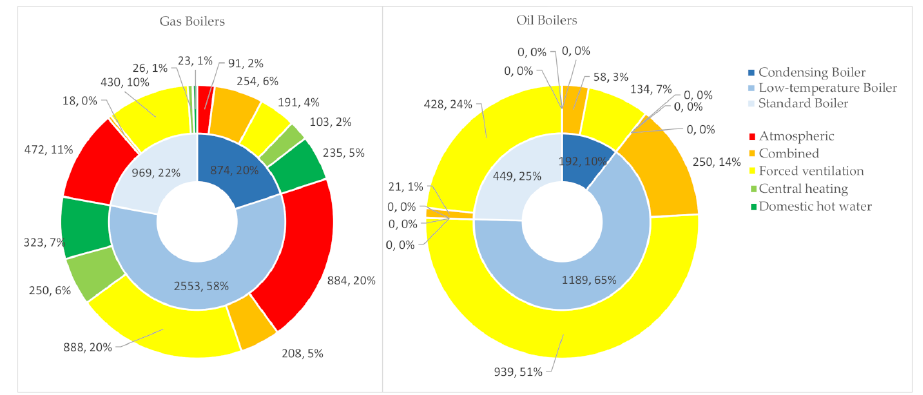
Figure 4. Share of boiler typologies and groups in the dataset expressed in “number of units” and “percentage” (e.g., 2553, 58% means 2553 units and 58%). Elaboration of [39].